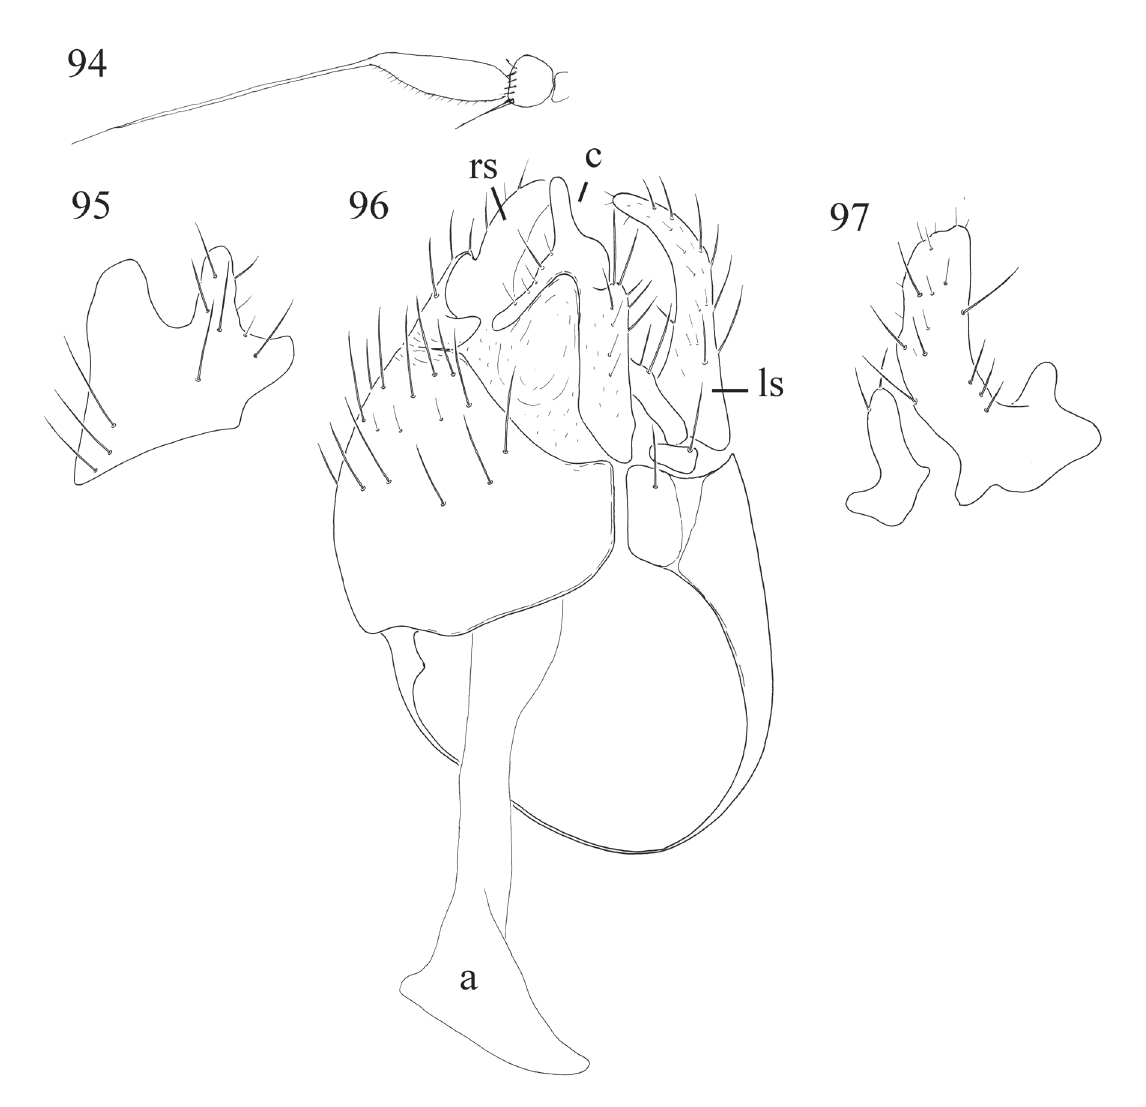
Figs 94-97. Drapetis hutan sp. nov., ♂. 94 . antenna, lateral view. 95 . right surstylus, dorsal view. 96 . epandrium and cerci. 97 . left surstylus, lateral